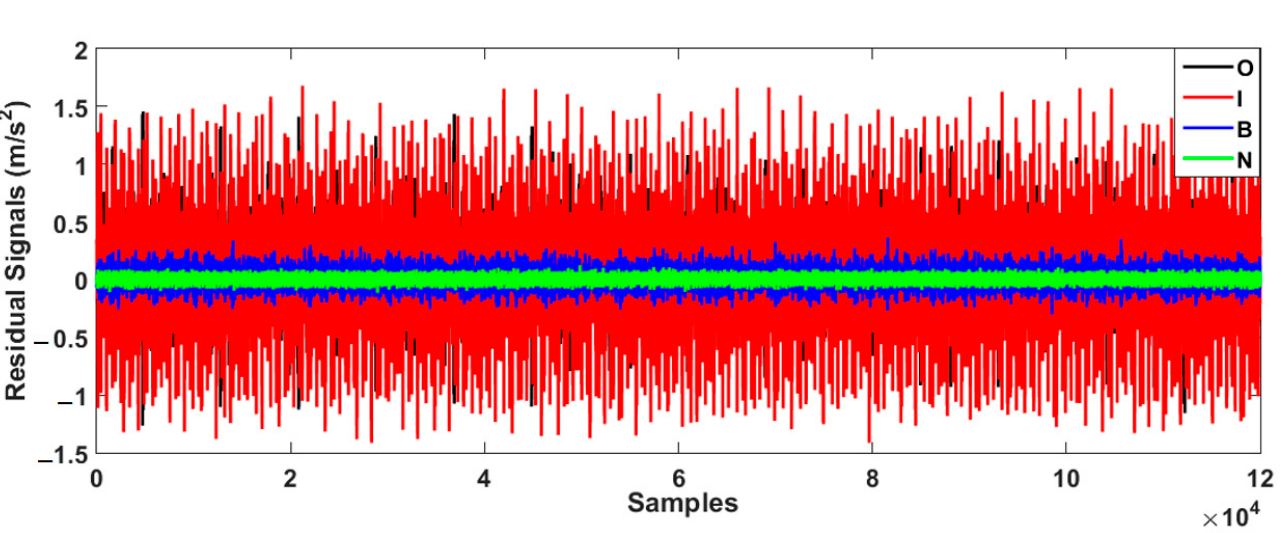
Figure 6. Bearing residual signals using the VS